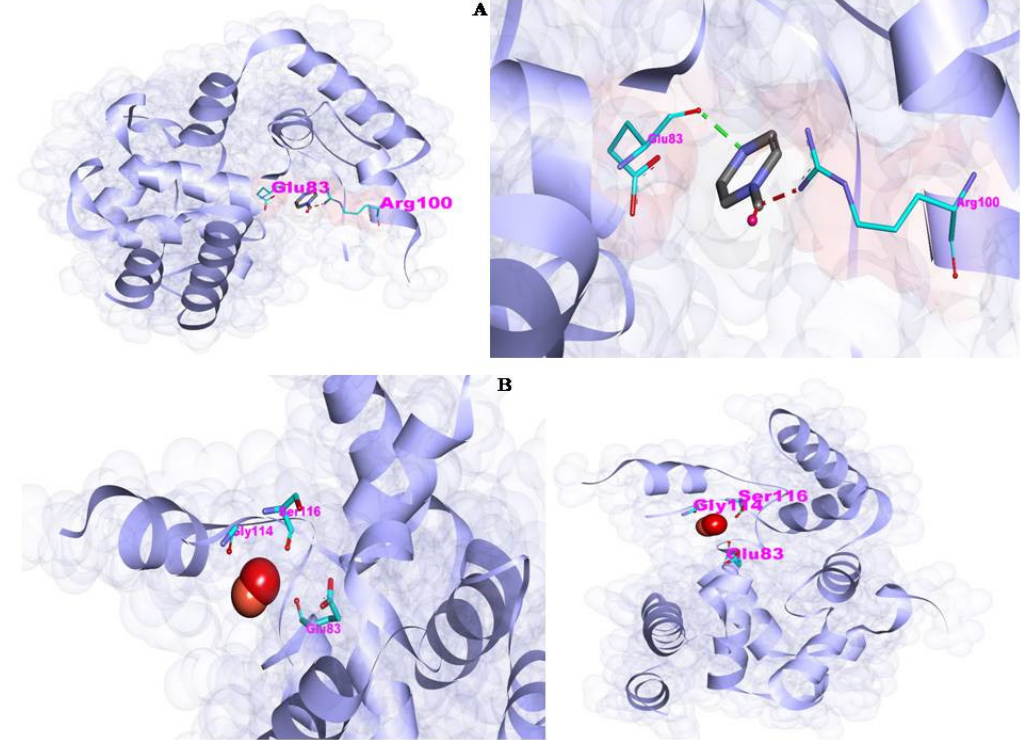
Figure 7. The binding interactions of synthesized rGO@ZnO–Cu nanoparticles with bacterial membrane glycan. In ( A ), the interaction with glycan is shown, and in ( B ), the interaction ofZnO–Cu with bacterial glycan is shown. Both synthesized particles bind with the bacterial glycan molecule through a hydrogen bond.